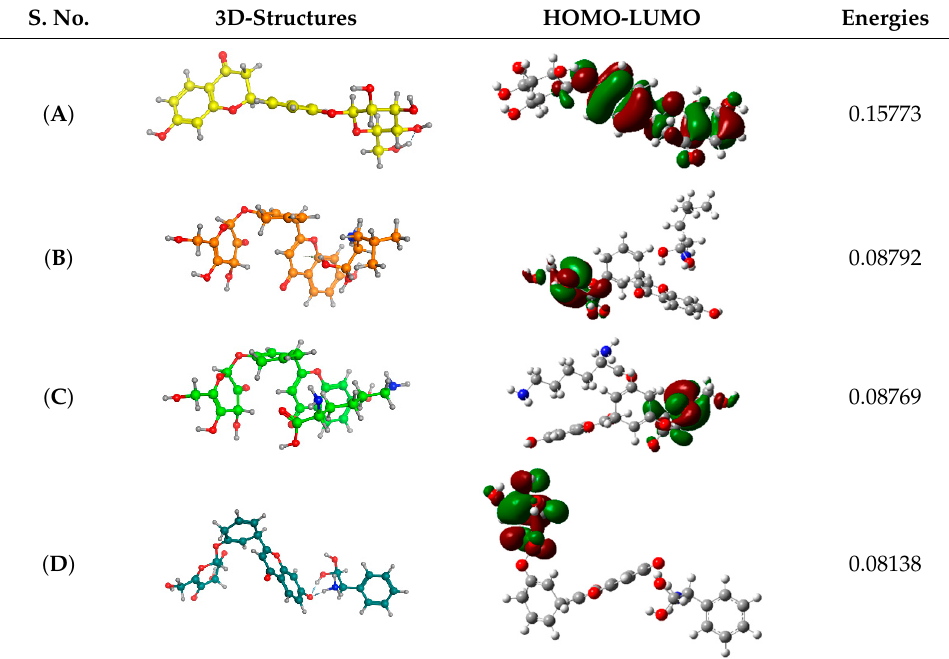
Table 5. ( A ) Liquiritin 3D structure, HOMO-LUMO, and band gap; ( B ) 3D structure of liquiritin complex with leucine amino acid, HOMO-LUMO, and band gap; ( C ) 3D structure of liquiritin complex with lysine amino acid, HOMO-LUMO, and band gap; ( D ) 3D structure of liquiritin complex with phenylalanine amino acid, HOMO-LUMO, and band